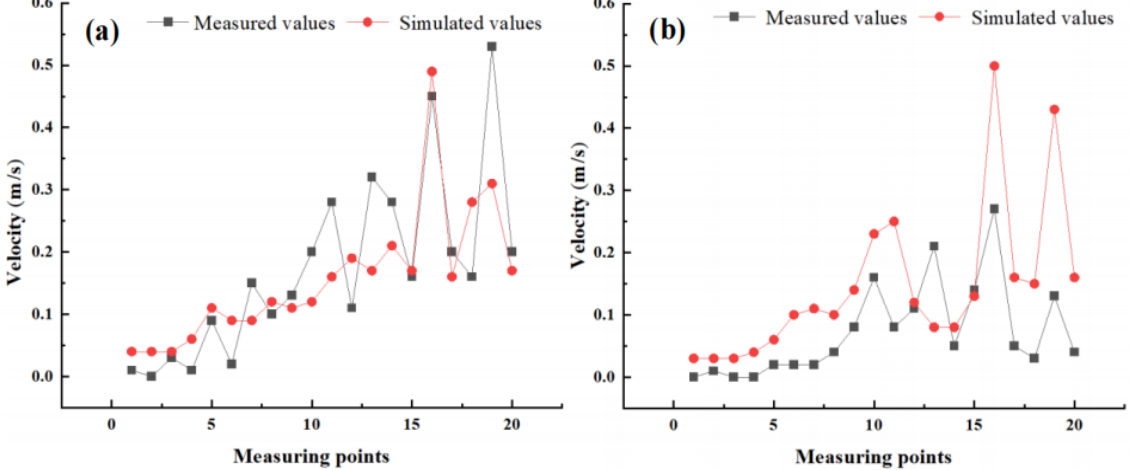
Figure 8. Comparison of measured and simulated velocity values of plane A ( a ) and plane C ( b ).